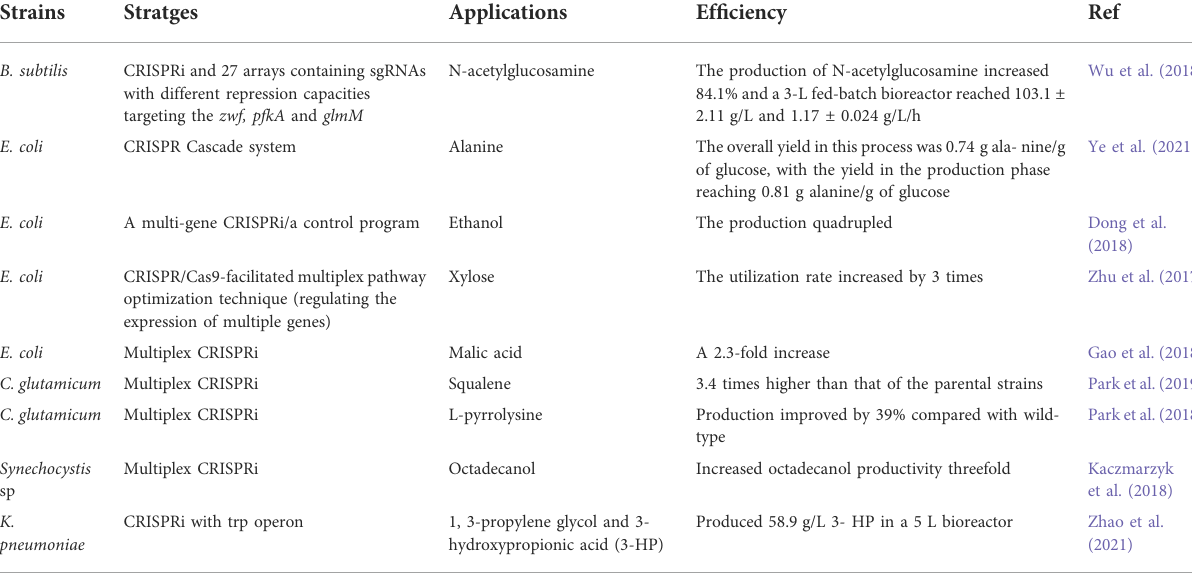
TABLE 2 Recent applications of CRISPR/Cas engineering in